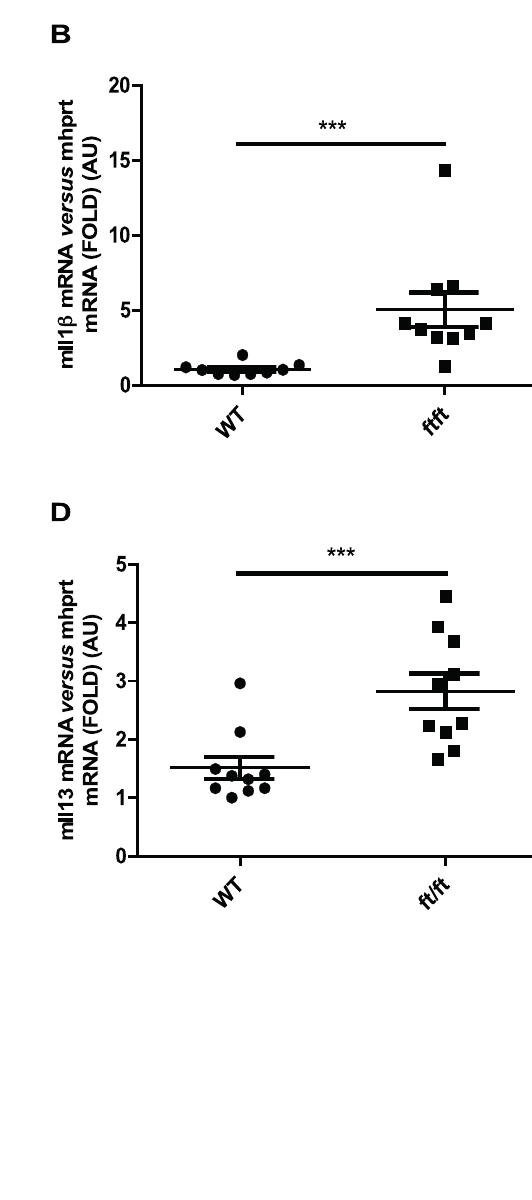
Total RNA from skin biopsies was extracted using the RNeasy Fibrous Tissue Mini Kit (Qiagen, Germany). RNA integrity was verified on an agarose gel under denaturating conditions. RNA (2 m g) was reverse-transcribed into cDNA using MMLV-reverse transcriptase (New England Biolabs, UK) as follows: 10 min at